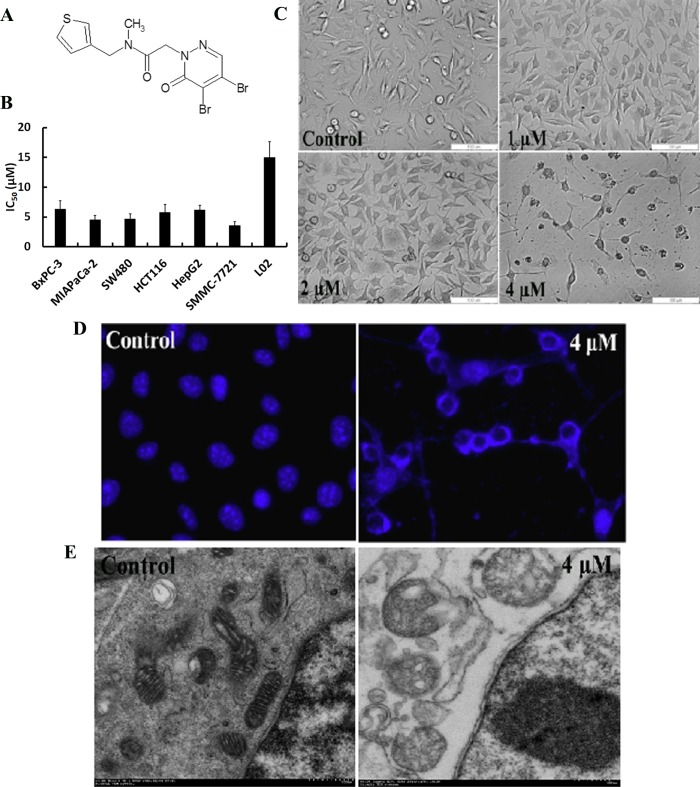
Chemical structure of IMB5043 and its effect on cancer cell lines.(A) Chemical structure of IMB5043. (B) IC50 of IMB5043 in various cancer cells. Cells were treated with different concentrations of IMB5043 for 24 h, and IC50 is calculated. Data shown are means ± SD. (C). Effect of IMB5043 on the morphology of SMMC-7721 cells were observed by bright field microscopy (100×). (D). Effect of IMB5043 on the nucleus of SMMC-7721 cells were observed by fluorescent microscopy (200×). The nucleus was staining by Hoest33342. (E) Effect of IMB5043 on the nucleus of SMMC-7721 cells were observed by Electron Microscopy (6000×). SMMC-7721 cells were incubated with indicated concentration of IMB5043 for 24 h. The representative picture is shown.